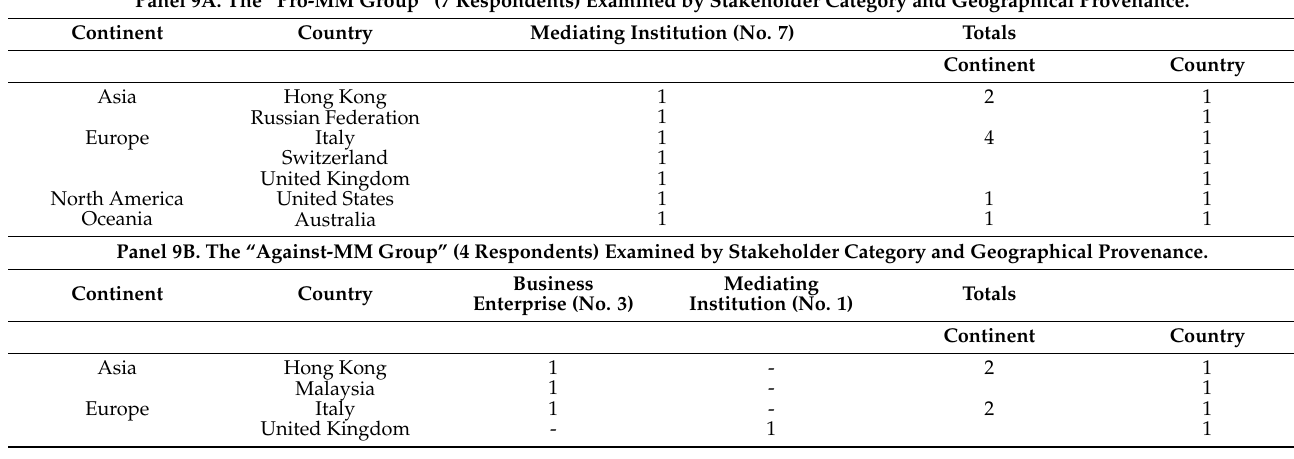
Table 9. Two main groups of opinions on MM: submitter demographics.